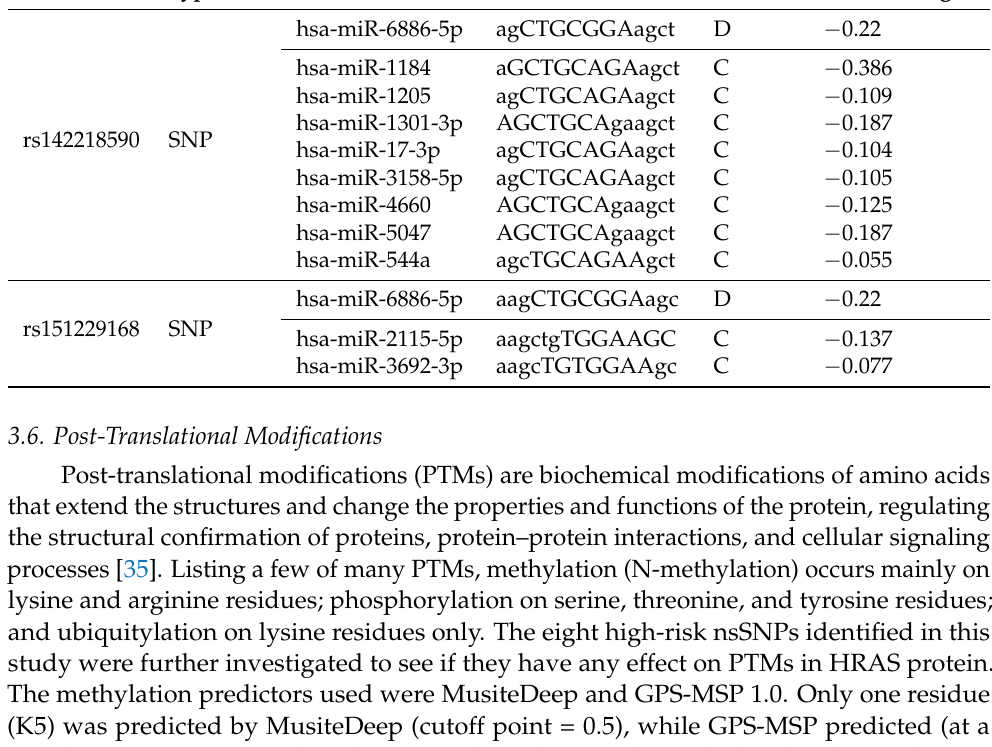
Table 4. Predicting the most deleterious missense nsSNPs of the protein isoforms of the HRAS gene. dbSNP